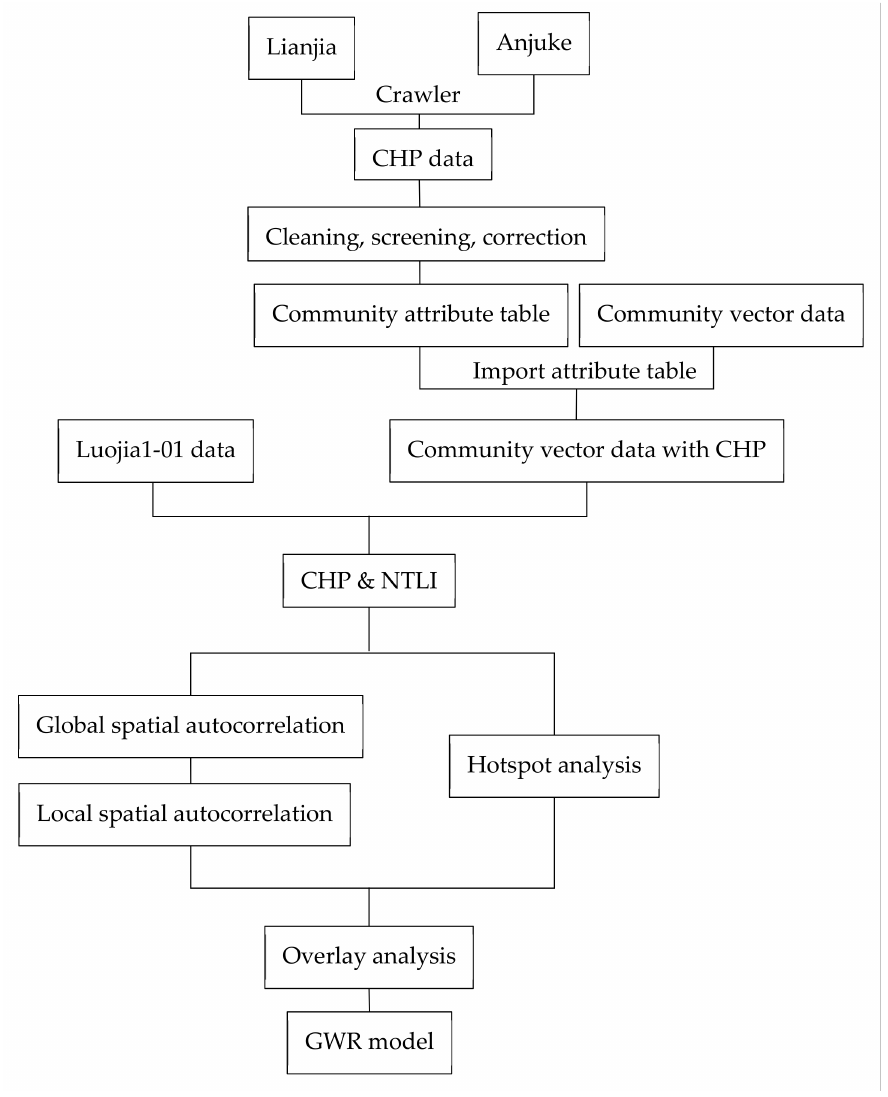
Figure 4. Technology